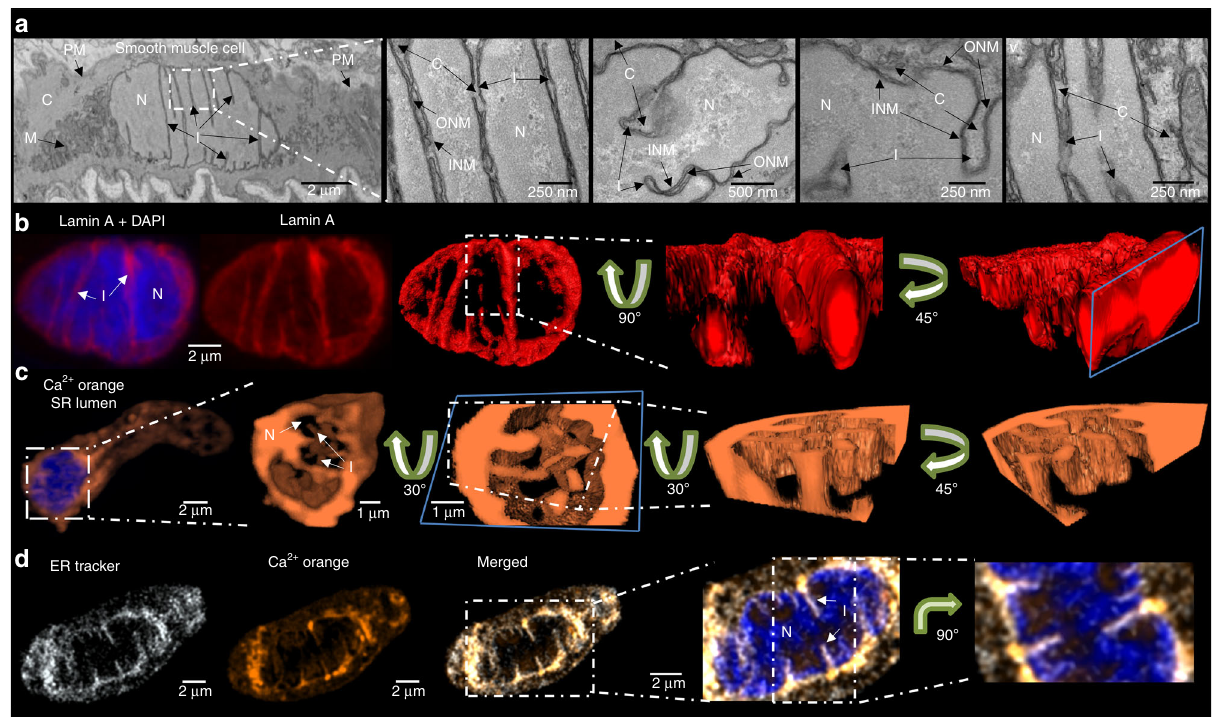
Fig. 4 Nuclear invaginations demarcate a releasable Ca 2 + store and cytoplasmic nanotubes. a Electron micrographs of artery sections, show (left to right) arterial smooth muscle cells at low and high magni fi cation and identify invaginations (I) of the inner (INM) and outer (ONM) nuclear membrane: PM plasma membrane, C cytoplasm, M mitochondria, N nucleus; con fi rmed in 4 arteries from 4 rats. b Left hand panel shows 3D reconstruction of a deconvolved z stack of confocal images through the nucleus of an arterial myocyte labelled for lamin A (red) with (left panel) and without (middle panel) DAPI (blue) to identify the nucleus (N) and its invaginations (I); con fi rmed in 54 cells from 14 rats. Right panel, higher threshold and ‘ digital surface skin ’ applied to select for nuclear invaginations by way of their higher density of labelling for lamin A. Then, higher magni fi cation transverse section through the 3D image of lamin A labelling shown at 2 different angles. c (left to right), 3D reconstruction of a deconvolved z stack of confocal images showing Calcium Orange fl uorescence (orange) from within the lumen of the sarcoplasmic (SR) and nucleoplasmic reticulum (SR) of an arterial myocyte, with the nucleoplasm identi fi ed (Draq5, blue), higher magni fi cation transverse section through the nucleus of same cell without Draq5 (N, nucleus; I, invaginations), application of digital skin (30° image rotation) and longitudinal section through the centre of the nucleus, then a transverse section through the nucleus (45° image rotation); con fi rmed in 5 cells from 3 rats. d (from left to right), Deconvolved confocal z section through the middle of a pulmonary arterial myocyte showing ER-tracker identi fi ed SR and outer nuclear membrane (white), Calcium Orange fl uorescence (orange), merged image showing ER-tracker and Calcium Orange fl uorescence, higher magni fi cation images with Draq5 identifying the nucleus and its invaginations (N, nucleus; I, invaginations), and a 90° rotation; con fi rmed in 4 cells from 3